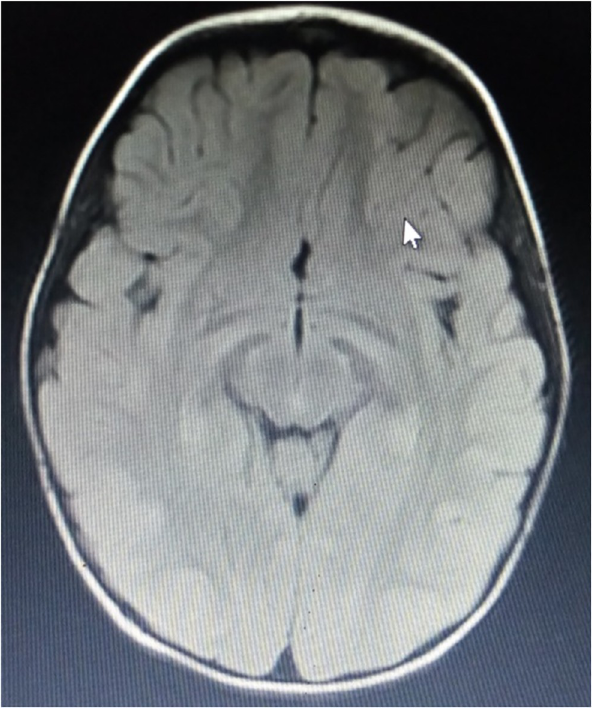
Fig 5. Case 30: MRI of a 3 year old patient with choreoathetoid CP. MRI of a 3 year old female patient born at term presenting with choreoathetoid CP, showing bilateral frontal lobe volume loss compared with the temporal-parietal and occipital formations and Bilateral basal ganglia posterior hyperintensity on axial T2 FLAIR.